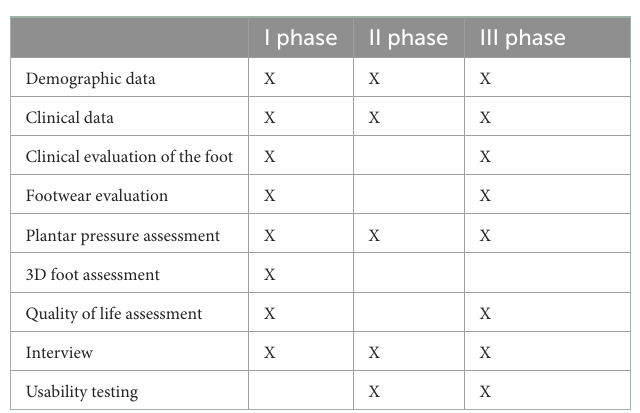
TABLE 3 Interventions in each phase of the